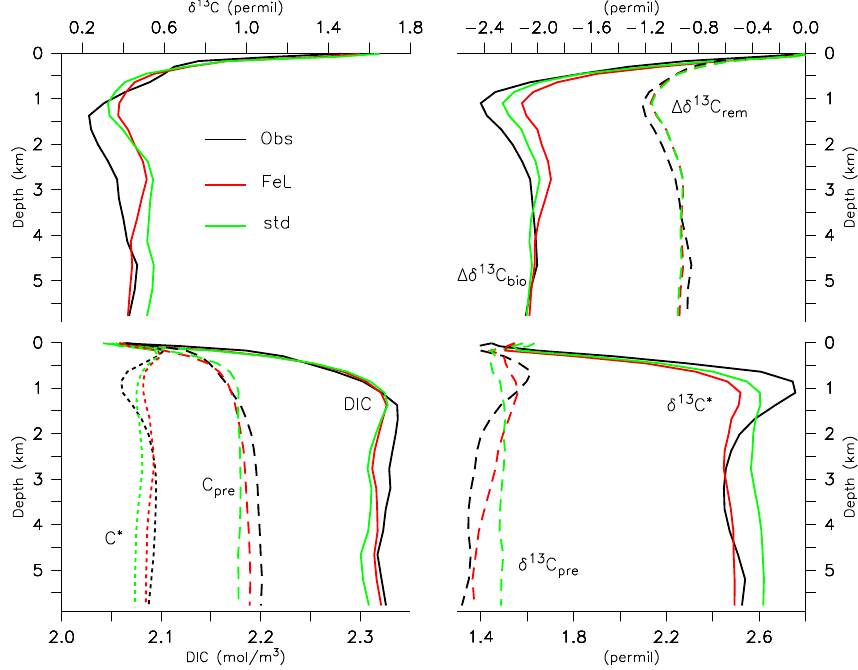
Fig. 10. As Fig. 5 but for the 1990s including observations (black) and models FeL (red) and std (green). Top left: δ 13 C DIC . Top right: 1δ 13 C bio (solid) and 1δ 13 C rem (dashed). Bottom right: δ 13 C ∗ (solid) and δ 13 C pre (dashed). Bottom left: DIC (solid), C pre (dashed), and C ∗